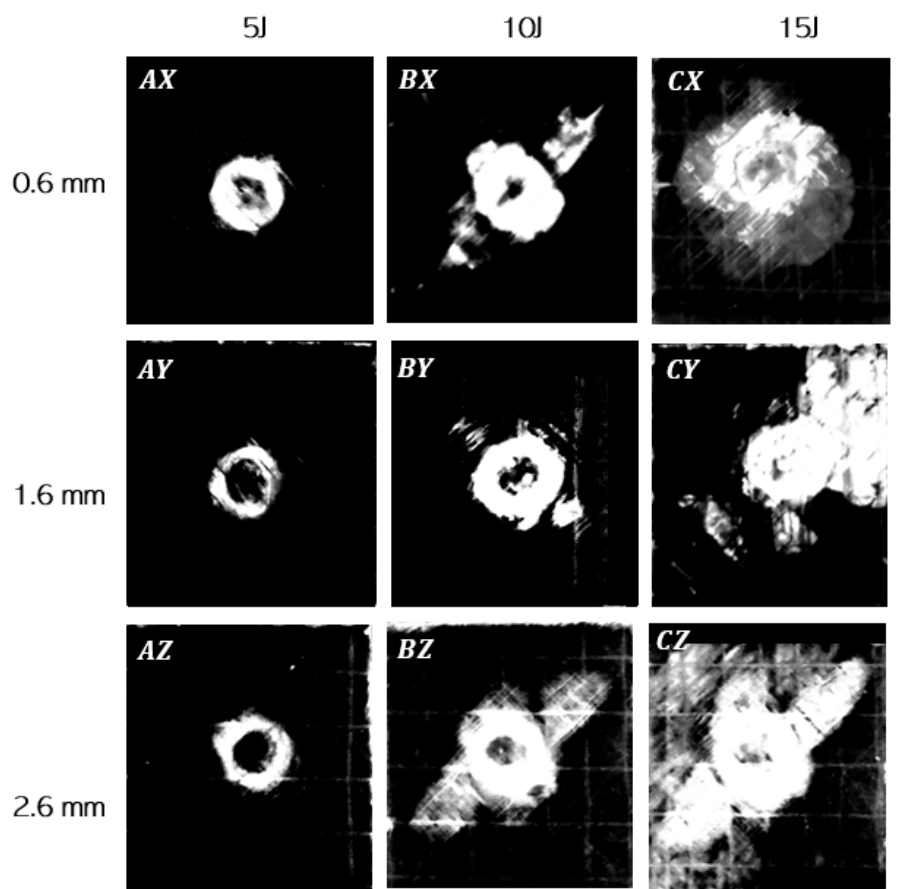
Figure 17. Projected damage area obtained in the joints with bondline thickness (0.6 mm, 1.6 mm, and 2.6 mm) and subjected to impact energy (5 J, 10 J, and 15 J).